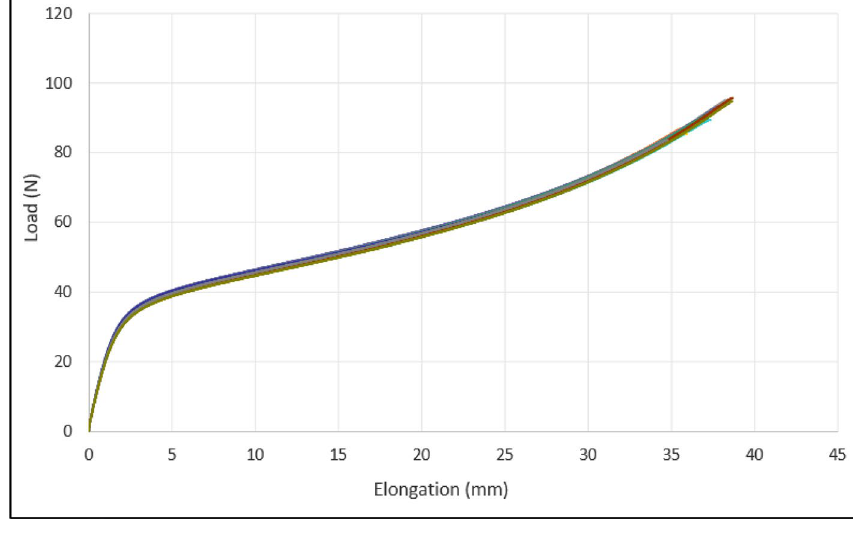
Fig. 35 Force elongation curves of individual specimen of paper